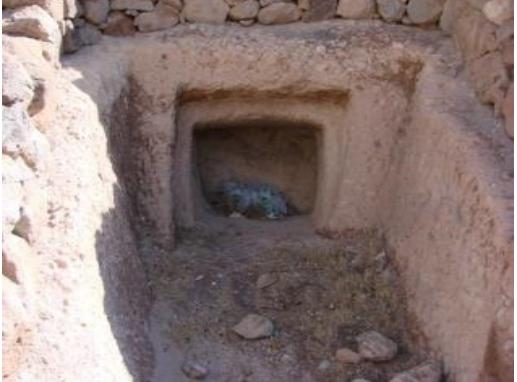
Figure 20. An unfinished kicheh in Meymand shows that the doorways should be completed before moving to other elements.